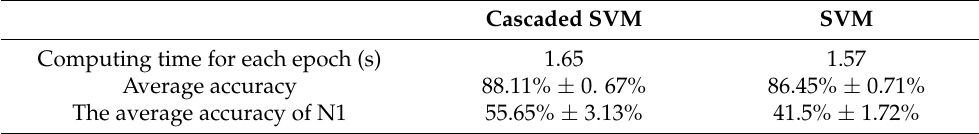
Table 3. The run time of training and testing of the Support Vector Machine for each epoch. Cascaded SVM SVM Computing time for each epoch (s) Average accuracy The average accuracy of